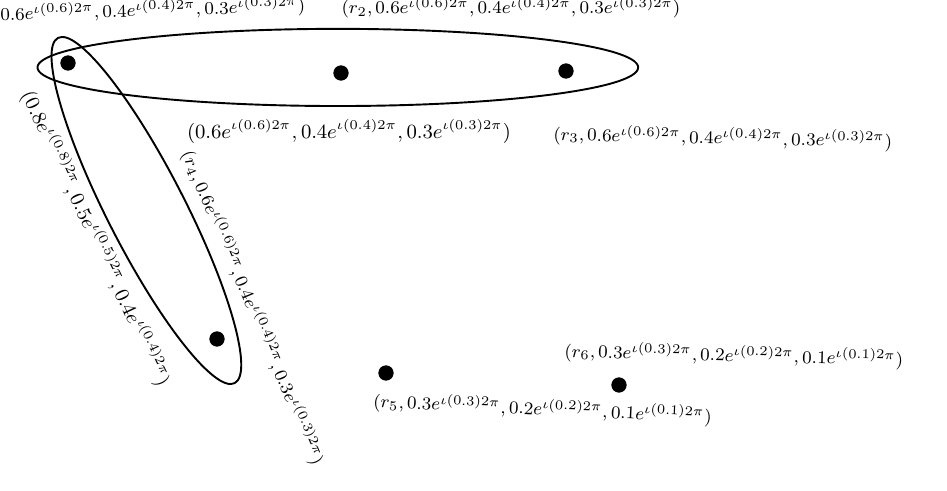
Figure 7. Upper truncation of